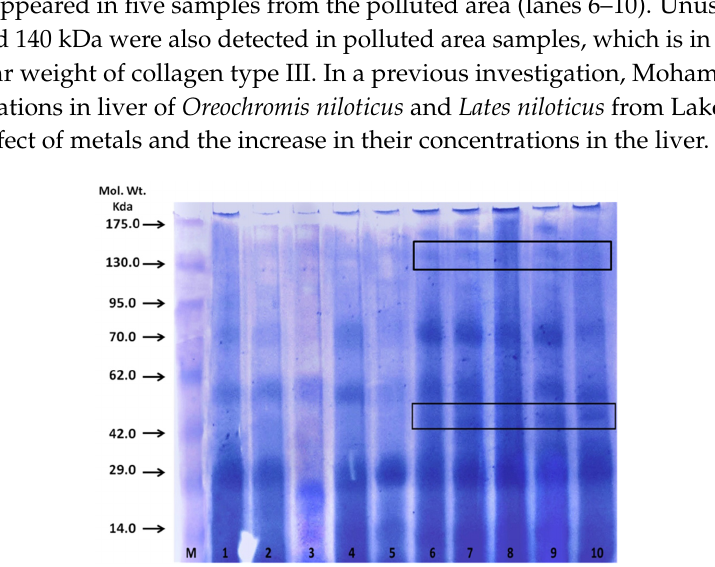
Figure 5. The electrophoretic patterns of proteins of liver of Variola louti fish caught in the reference (1–5) and polluted areas (6–10).